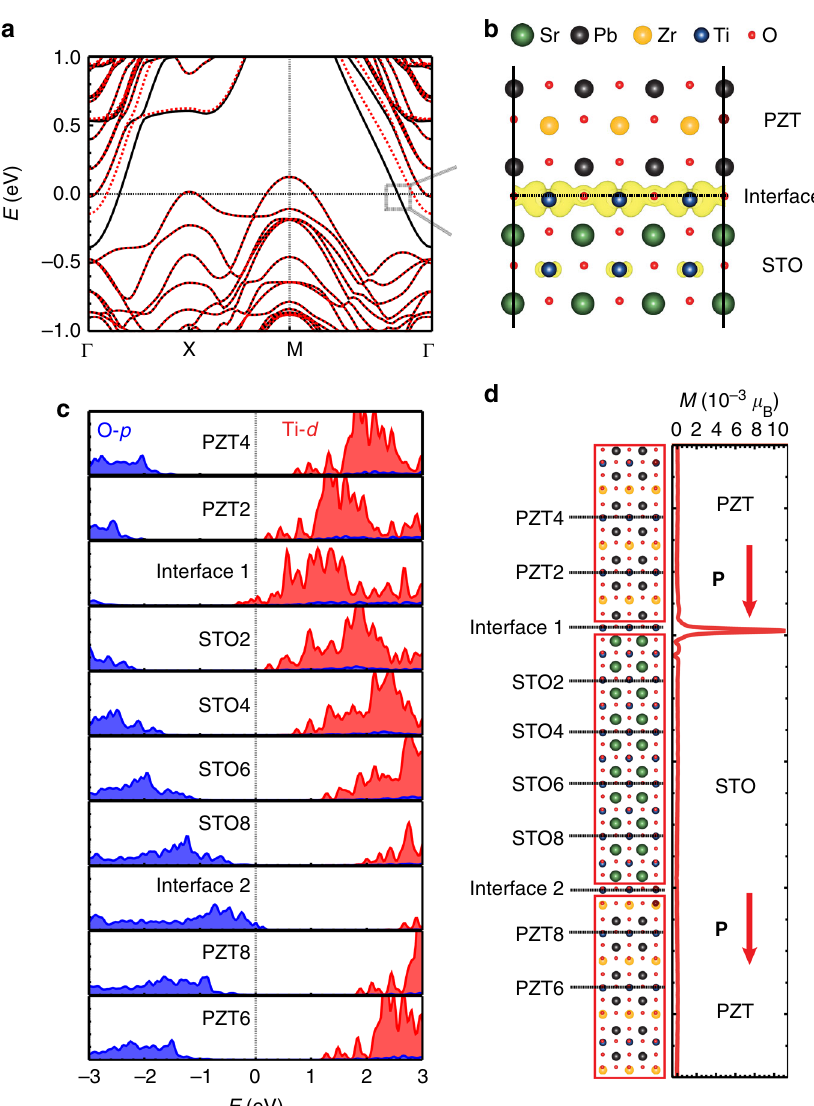
Fig. 4 Theoretical calculations. a Calculated band structure of the STO/PZT heterostructure with U eff = 2.3 eV for Ti and Zr d -orbitals. The majority-spin and minority-spin bands are represented by black solid and red dashed lines, respectively. b The squared wave-function of the state that crosses the Fermi level. c Atom-resolved DOS of the STO/PZT heterostructure. The vertical dashed line at E = 0 represents the position of the Fermi level. Blue and red colors denote O-2 p and Ti-3 d contributions, respectively. d The planar-average of spin density of the STO/PZT heterostructure along the polarization ( P ) axis. The corresponding atomic structure is shown in the left